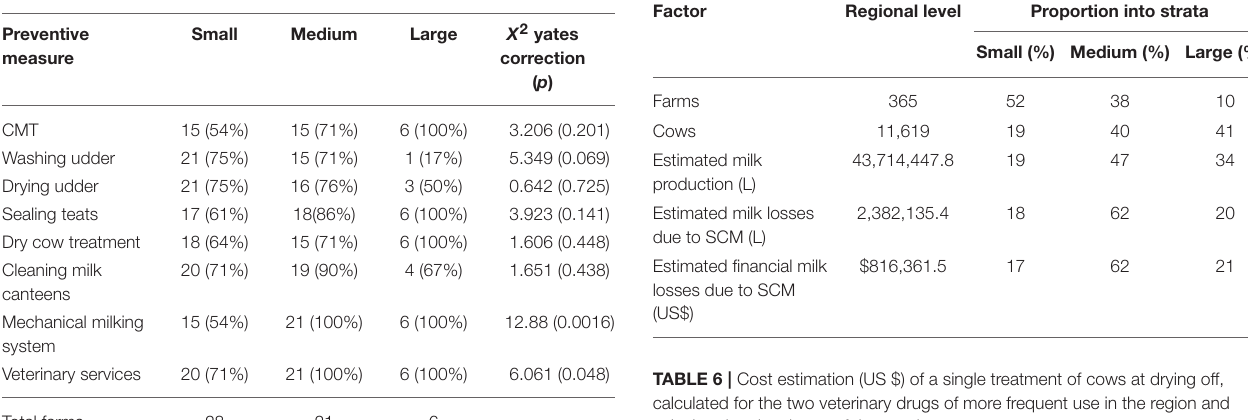
TABLE 3 | Number (percentage) and frequency of use of preventive measures for subclinical mastitis in farms participating in the cross-sectional study, arranged by strata (n: 55).